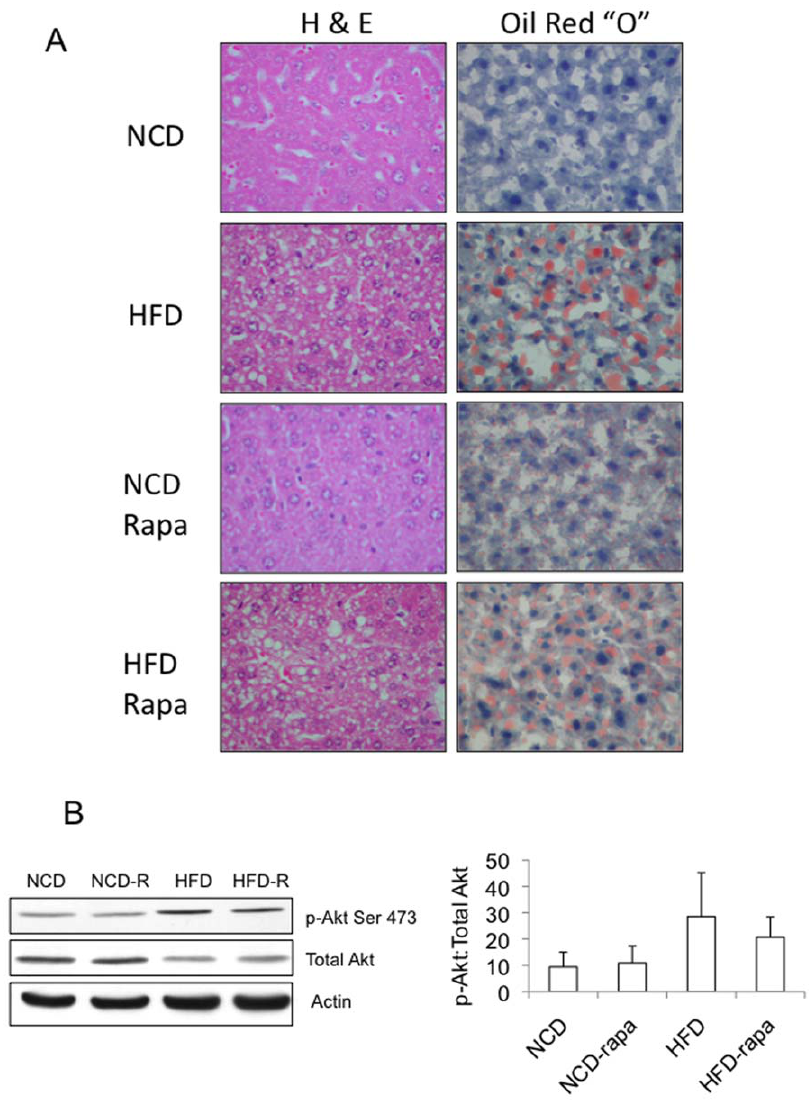
Figure 5. Histologic and biochemical effects of rapamycin on HFD-induced steatosis. A) Examples of histology (H&E) and Oil Red ‘‘O’’ staining of the livers procured from animals described in Figure 4. NCD, normal chow diet; HFD, high-fat diet; Rapa, rapamycin. Magnification, 400X. B) Western blots of representative liver lysates from each of the four groups shown in (A) highlighting the effects of chronic rapamycin on Akt(Ser473) phosphorylation. The average ratios of band intensities (Image J) between phospho- and total-Akt are summarized in the graph (n of 5 per